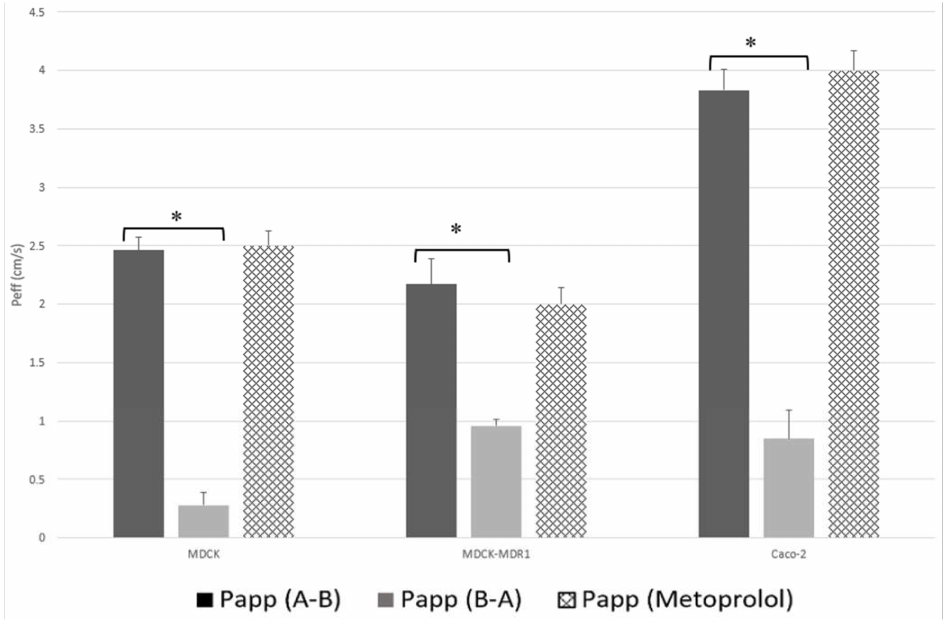
Figure 2. Comparison of apparent permeability values (Papp × 10 − 5 cm/s) measured for JM-20 using MDCK, MDCK-MDR1 and Caco-2 cell lines. Results were compared with permeability value of metoprolol. * Significant differences at p < 0.05.